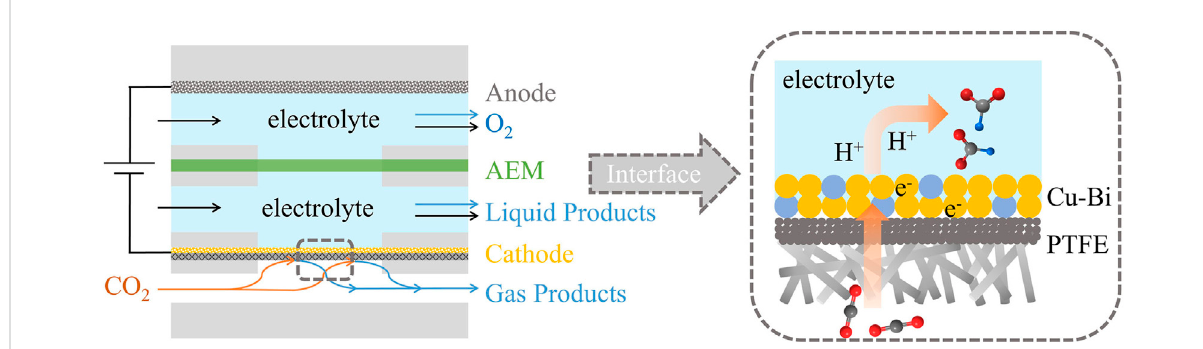
Schematic of Cu-Bi electrocatalyst on PTFE for electroreduction of CO 2 in a fl ow cell.